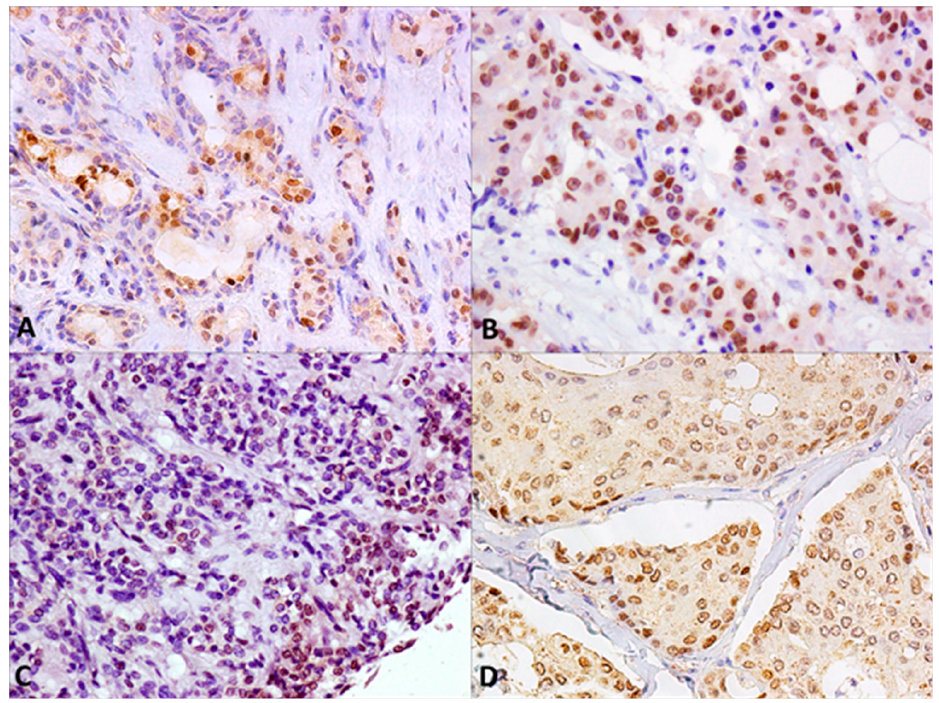
Figure 2. Nuclear AR IHC staining of SGTs samples: ( A ) Pleomorphic Adenoma (PA); ( B ) Oncocytic carcinoma; ( C ) Myoepithelioma; ( D ) Mucoepidermoid Carcinoma (MEC) (Magnification 20×).